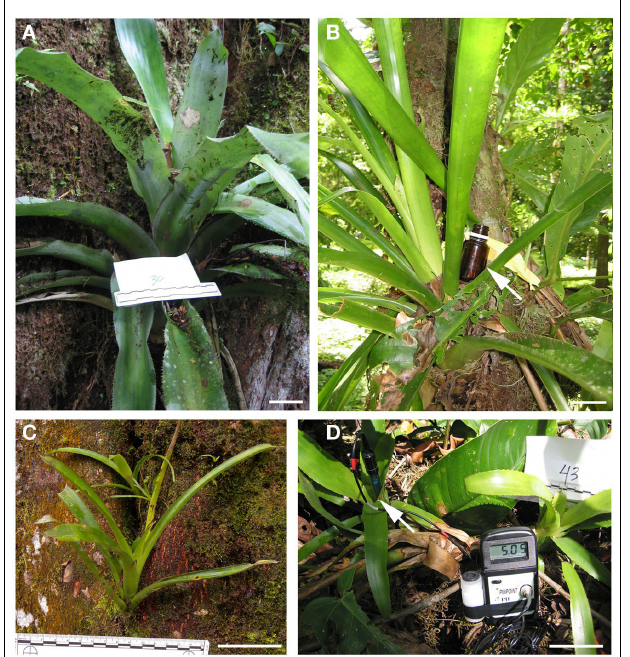
FIGURE 1 | Costa Rican bromeliads used in this study. (A) Aechmea mariae-reginae with nearby note card and ruler for scale (B) Werauhia gladioliflora , with nearby amber bottle (arrow) intended to artificially simulate a bromeliad tank. (C) A juvenile specimen of W. gladioliflora . (D) Two specimens of W. gladioliflora , showing a pH electrode (arrow) and meter, reading 5.05 in the central catchment water of the left hand specimen. Scale bars,